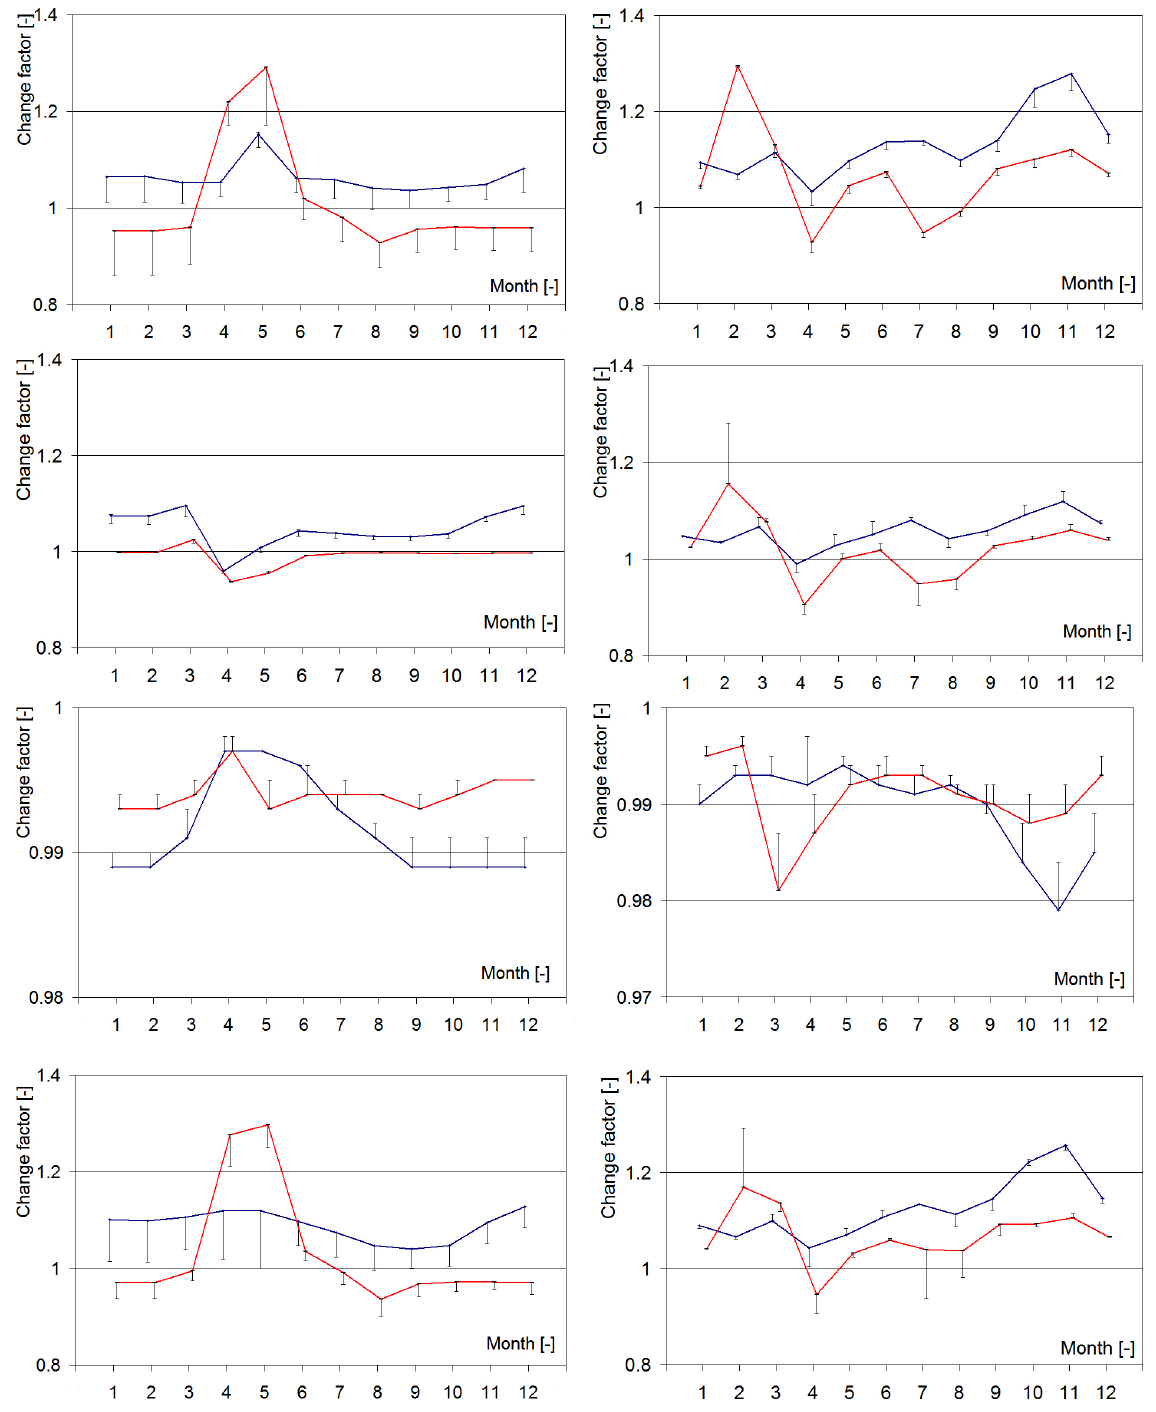
Fig. 12. Mean level of impact results on mean monthly flows for climate variables (precipitation, 2nd row; temperature, 3rd row; ETo, 4th row; all 3, 1st row) at BYBLK (blue line) and DSK (red line) gauging stations after VHM (left column) and MIKE-SHE (right column) simulations (lines connect the A1B results). The horizontal lines represent the impact results of the A1B scenario, while the small bars represent the max and min impact results of the 3 scenarios (A1B, A2 and